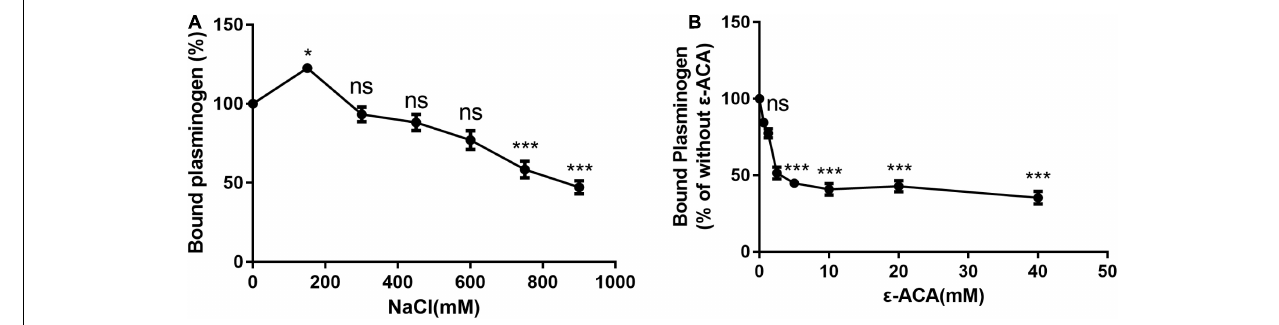
FIGURE 2 | Assessment of factors that may affect SsPepO and plasminogen binding. (A) Microtiter plates were coated with SsPepO, and the effect of different concentrations of NaCl on the binding of plasminogen (5 µ g/ml) to SsPepO was analyzed. (B) The inhibitory effect of the lysine analog (cid:15) -ACA on the binding of plasminogen to SsPepO was evaluated. These assays were repeated three times, and the results were represented as the mean ± SD. ns, not significant; * p < 0.05; ** p < 0.01; *** p <